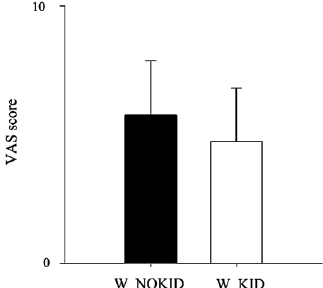
Figure 1. Results of perceived stress evaluation according to the Visual Analogue Scale (VAS) in W_NOKID (dark bar) and W_KID (white bar). Results are presented as mean ± standard deviation.